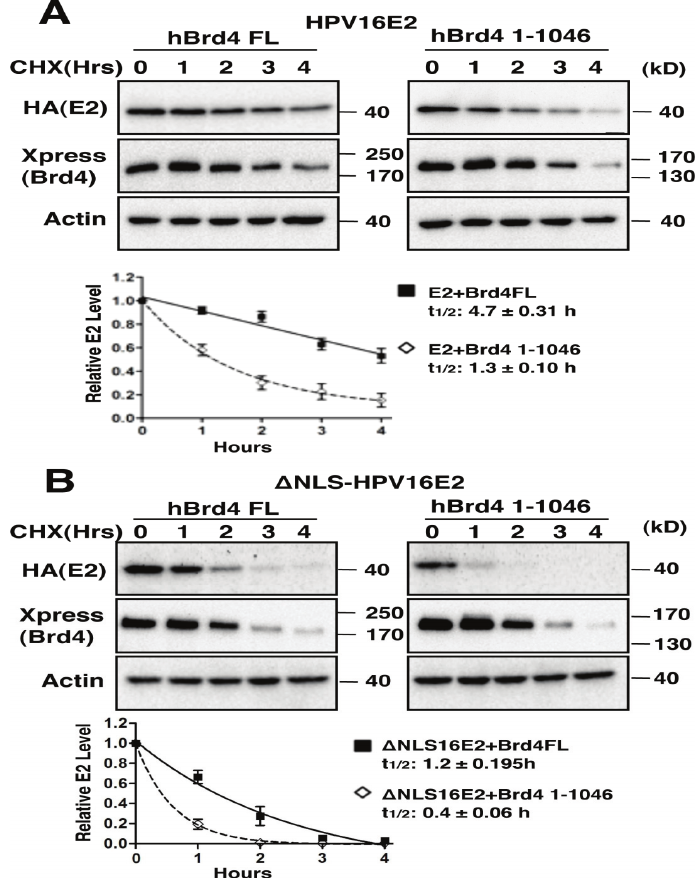
Figure 3. Brd4 stabilizes both HPV16 E2 and an HPV16 E2 nuclear localization mutant. ( A ) C33A cells were transfected with pOZN-HPV16E2 and either pcDNA4C-hBrd4FL or pcDNA4C-hBrd4 1-1046. Cells were treated with 100 μ g/mL cycloheximide (CHX) at 24 h after transfection for the lengths of time indicated. Cell lysates were harvested and analyzed by Western blotting using HA (for 16E2), Xpress (for Brd4) and actin antibodies. Representative blots are shown. Protein bands from the immunoblots were quantitated with Image J software, using the actin signal for normalization. Signal intensities were then normalized to the 0 h time point. Error bars represent the standard deviation from three independent experiments. Half-lives were calculated using a one-phase exponential decay model; ( B ) C33A cells were transfected with pOZN- Δ NLSHPV16E2 and,